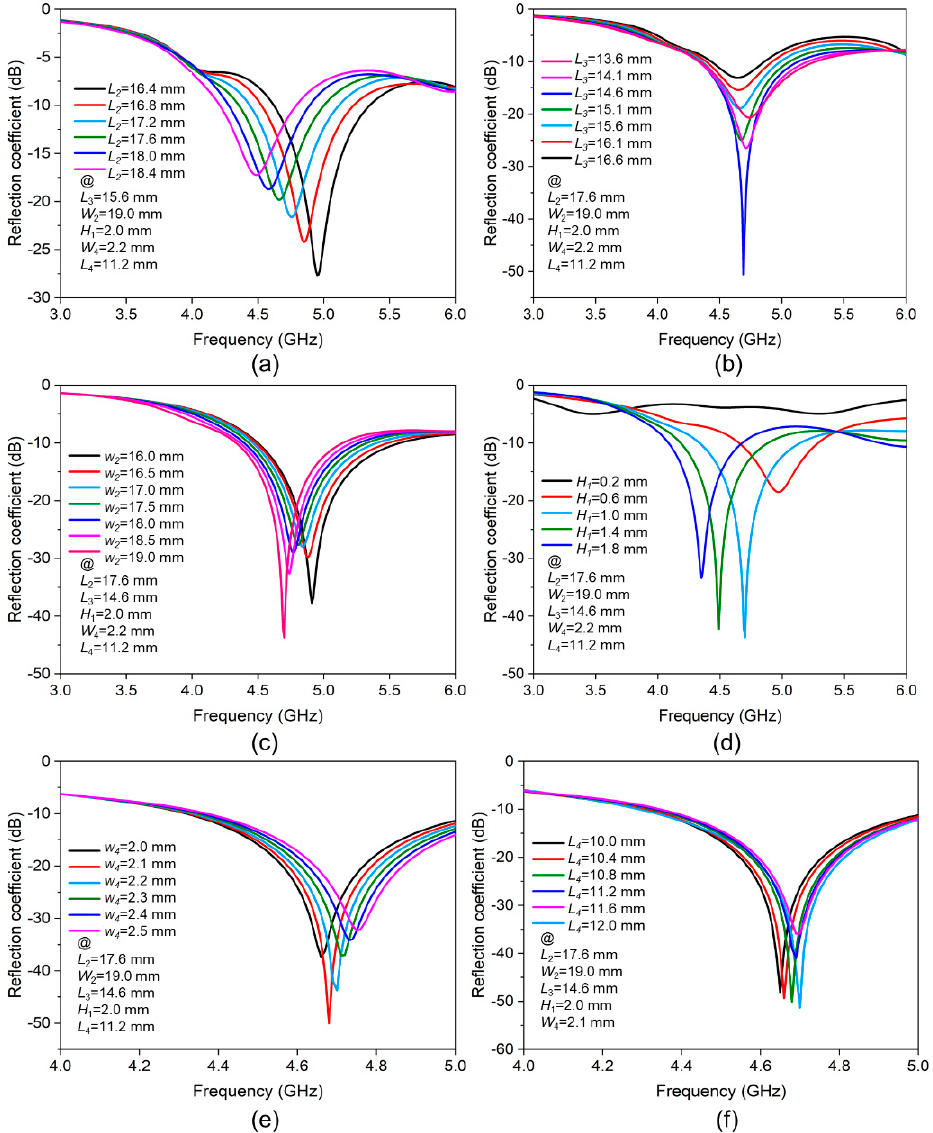
Figure 2. The impact of geometric parameters on the reflection coefficients of the antenna: ( a ) L 2 , ( b ) L 3 , ( c ) W 2 , ( d ) H 1 , ( e ) W 4 , and ( f ) L 4 .